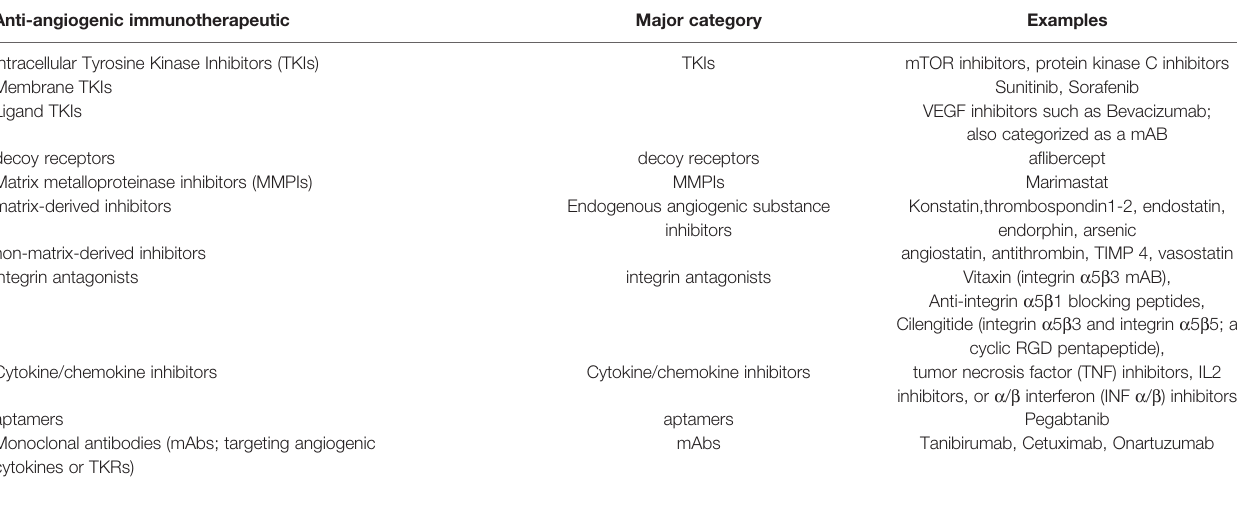
TABLE 1 | Major categories of anti-angiogenic immunotherapeutics. Anti-angiogenic